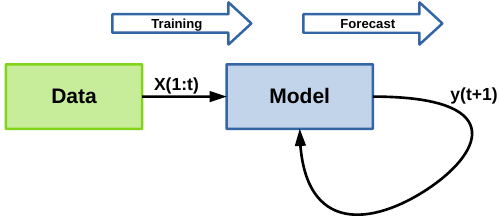
Figure 4. Model training and forecast structure.